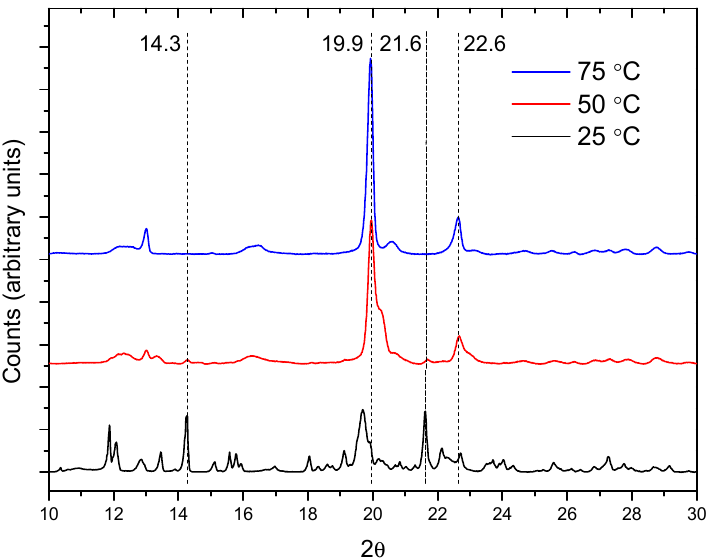
Figure 4. XRD patterns for the reaction between PEG400 and α -CD (1:1 molar ratio) after 24 h. The XRD data have been analyzed to evaluate the kinetic parameters of the crystal formation process, although in this case the number of points obtained per curve is consid- erably lower compared to FTIR due to practical reasons. As an example, Figure 5 shows the kinetic profile of the reaction of PEG400 (1:0.5 and 1:1 ratios) at 50 and 75 ◦ C, obtained from the peak areas at 2 θ = 19.9 ◦ (PPR). It can be seen how the crystalline adduct, PPR c , is practically formed after 6 h.